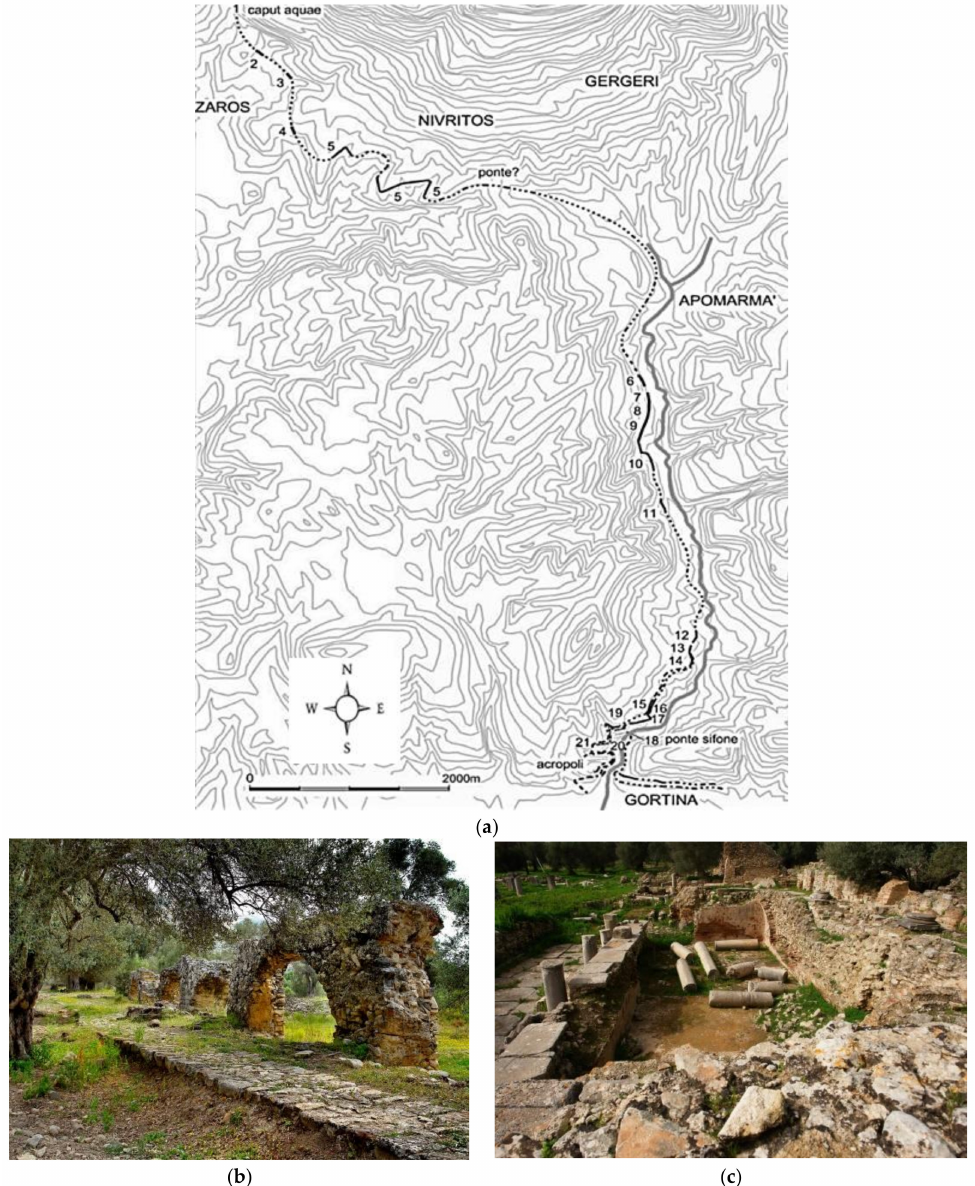
Figure 8. Gortys aqueduct: ( a ) the layout [32], ( b ) the remnants of it before reaching Praetorium and ( c ) Cistern in Praetorium (photos by A. N.